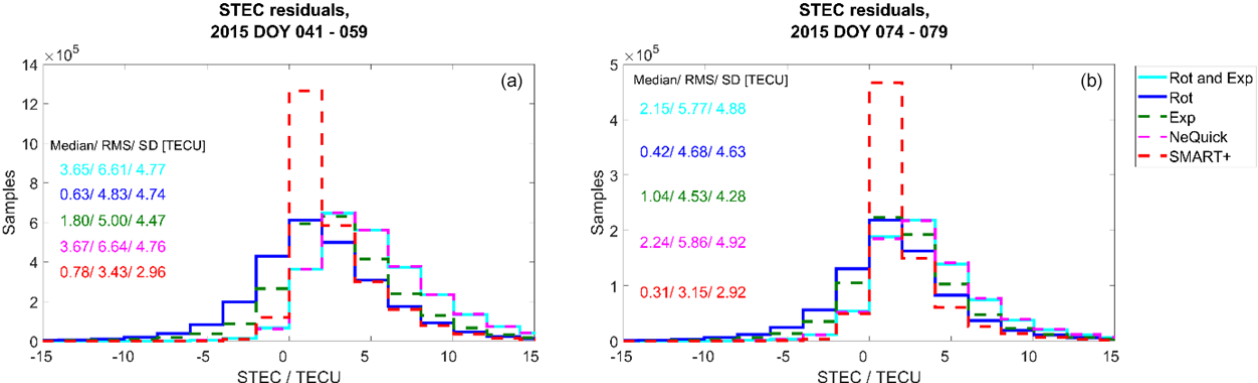
Figure 8. Plausibility check of the residuals calculated as measured STEC minus estimated STEC. (a) Residuals of the quiet period and (b) for the perturbed